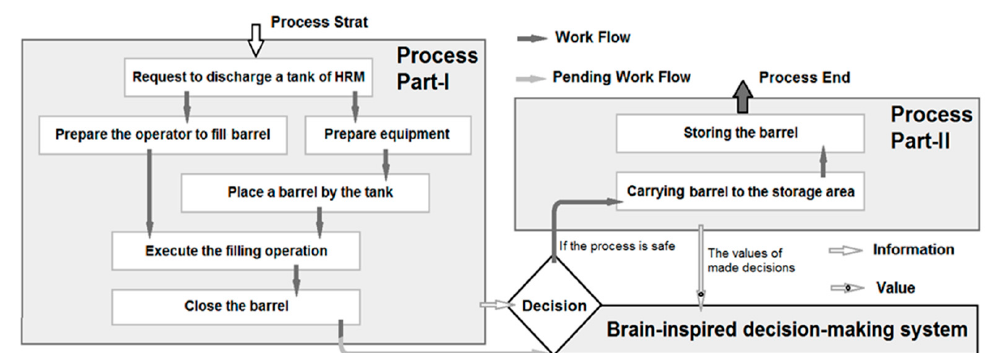
Figure 1. Diagram of our intelligent operational risk management system in a chemical product production process. Figure 1 shows a schematic of the complete states of the simulation. The process begins in the simulation part-I. The workflow from part-I can only proceed if the decision-making system allows the process to continue to part-II. The decision-making system receives the information it needs to decide to allow the process to continue (or not) from part-I. The added value of each decision after making reaches the decision-making system through part-II, and the system updates its alternatives accordingly.